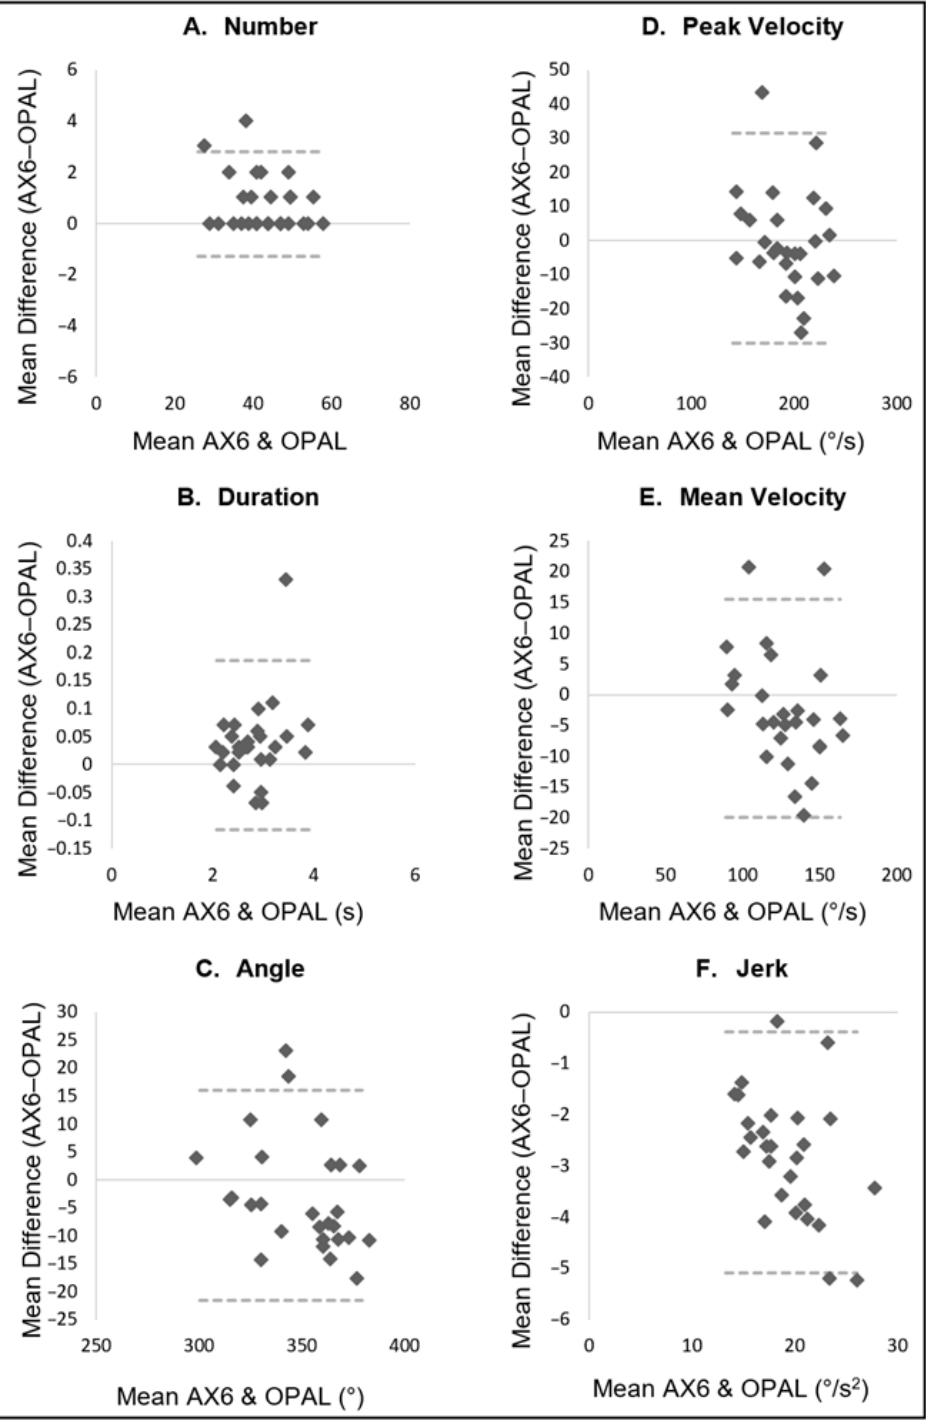
Figure 5. Turning in Place task: Bland–Altman plots displaying agreement between AX6 and OPAL for ( A ) Number, ( B ) Duration, ( C ) Angle, ( D ) Peak velocity, ( E ) Mean velocity, ( F ) Jerk.